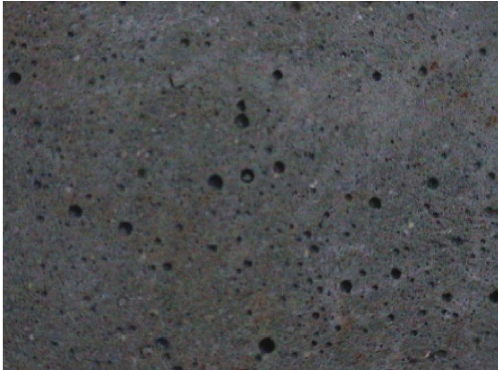
Figure 8: The section of optimal proportion.